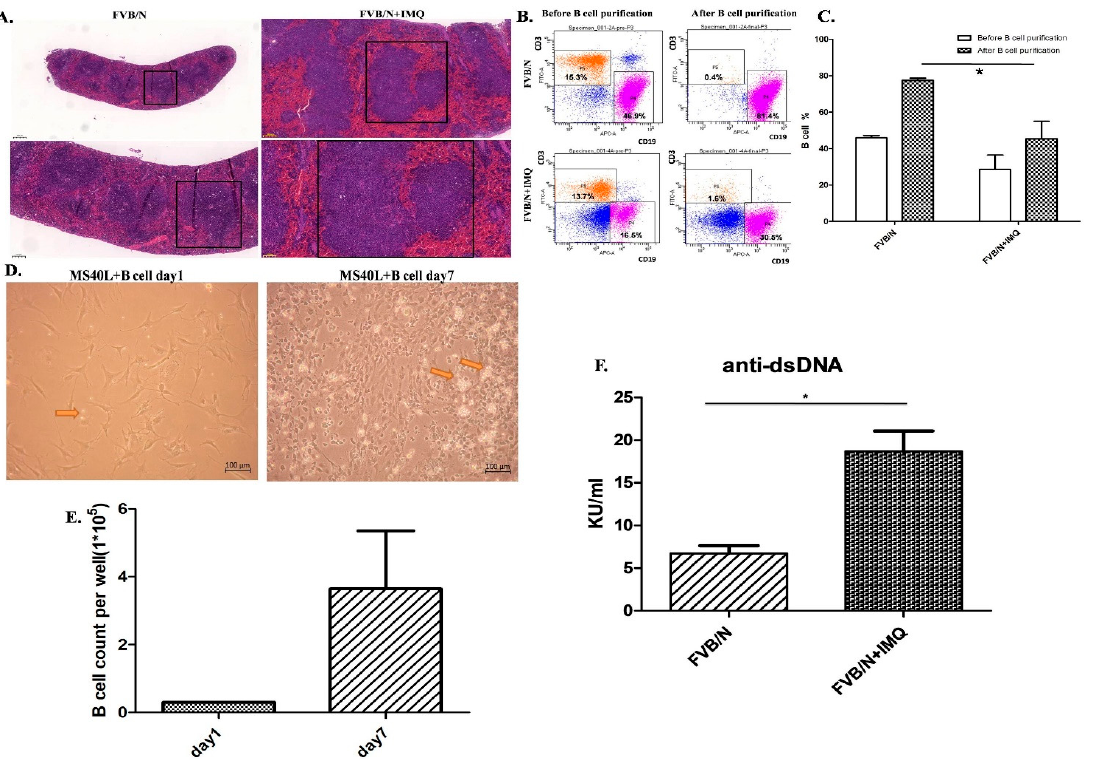
Figure 2. Spleen and B-cell purification from the splenocytes from the mice before and after IMQ stimulation. B-cell function differences are demonstrated with anti-dsDNA autoantibody secretion as determined by ELISA kit. ( A ) The H&E stain of the FVB/N group and the FVB/N + IMQ mouse spleen is demonstrated with one of three experiments on three different mice specimens. The ger- minal centers of FVB/N + IMQ mouse spleen show enlargement, cell proliferation, and hyperactiva- tion. The left two panels are pictures of 50-times and 100-times magnifications of the original FVB/N spleen specimens. The right two panels are pictures of 50-times and 100-times magnifications of the original FVB/N + IMQ spleen specimens. ( B ) The flow cytometry analysis from mouse splenocytes. The left two panels are splenocytes, and the data are demonstrated with one of three individual experiments. These three different experiments have comparable results. The results show that the CD19(+)B cells are 46.9% of total splenocytes and T cells are 15.3% of splenocytes in FVB/N mouse; the CD19(+)B cells are 16.5% of total splenocytes and T cells are 13.7% of splenocytes in FVB/N + IMQ mouse. The right two panels are B cells after negative B-cell selection from the splenocytes. The results show that the CD19(+)B cells are 81.4% of total splenocytes and T cells are 0.4% of splenocytes in FVB/N mouse; the CD19(+)B cells are 30.5% of total splenocytes and T cells are 1.6% of splenocytes in FVB/N + IMQ mouse. ( C ) Histogram of ( B ) The X-axis is the grouping, and the Y-axis is the pro- portion of B cells in the total number of cells collected. The FVB/N group had an average of 45.9% before purification and an average of 77.48% after purification; the FVB/N + IMQ group had an average of 28.58% before purification and an average of 45.36% after purification ( n = 3 per group, * indicates p -value < 0.05). ( D ) The picture taken on day 1 (right panel) and day 7 (left panel) from the B cells co-cultured with the CD40L feeder cells. The arrow indicates B cell. ( E ) The number of B cells per well in 6-well plate after 7 days of culture. On the first day, 3 × 10 4 B cell/well in 6-well plate was fixed and on the 7th day, the average was 3.64 × 10 5 B cell/well in a 6-well plate ( n = 3 per group, * indicates p -value < 0.05). ( F ) The titers of the anti-dsDNA autoantibody were determined by ELISA for four different individual experiments in each group. Data are expressed as mean ± standard deviation and comparison was performed by Mann–Whitney test. The mark * indicates a p -value less than 0.05.